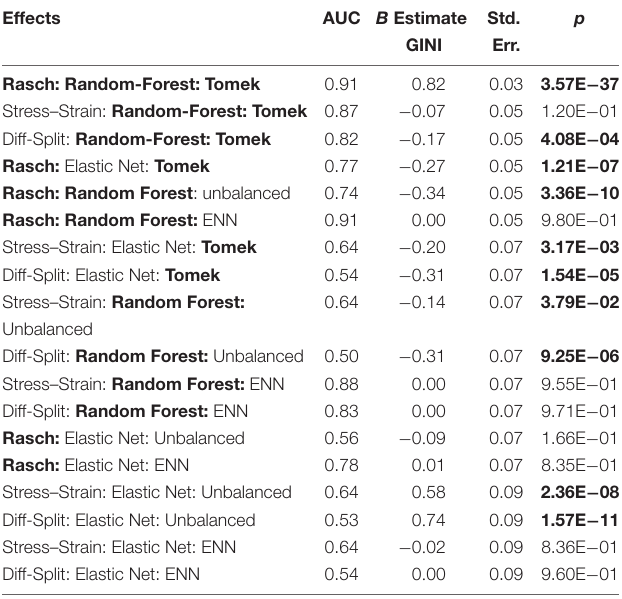
TABLE 4 | Working memory